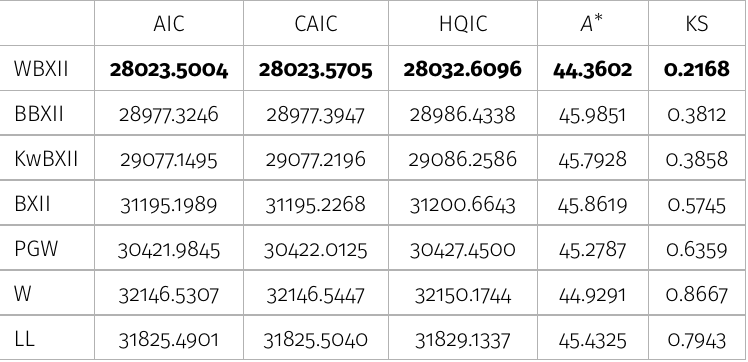
Table X. Goodness-of-fit statistics for the fitted models for baseball players